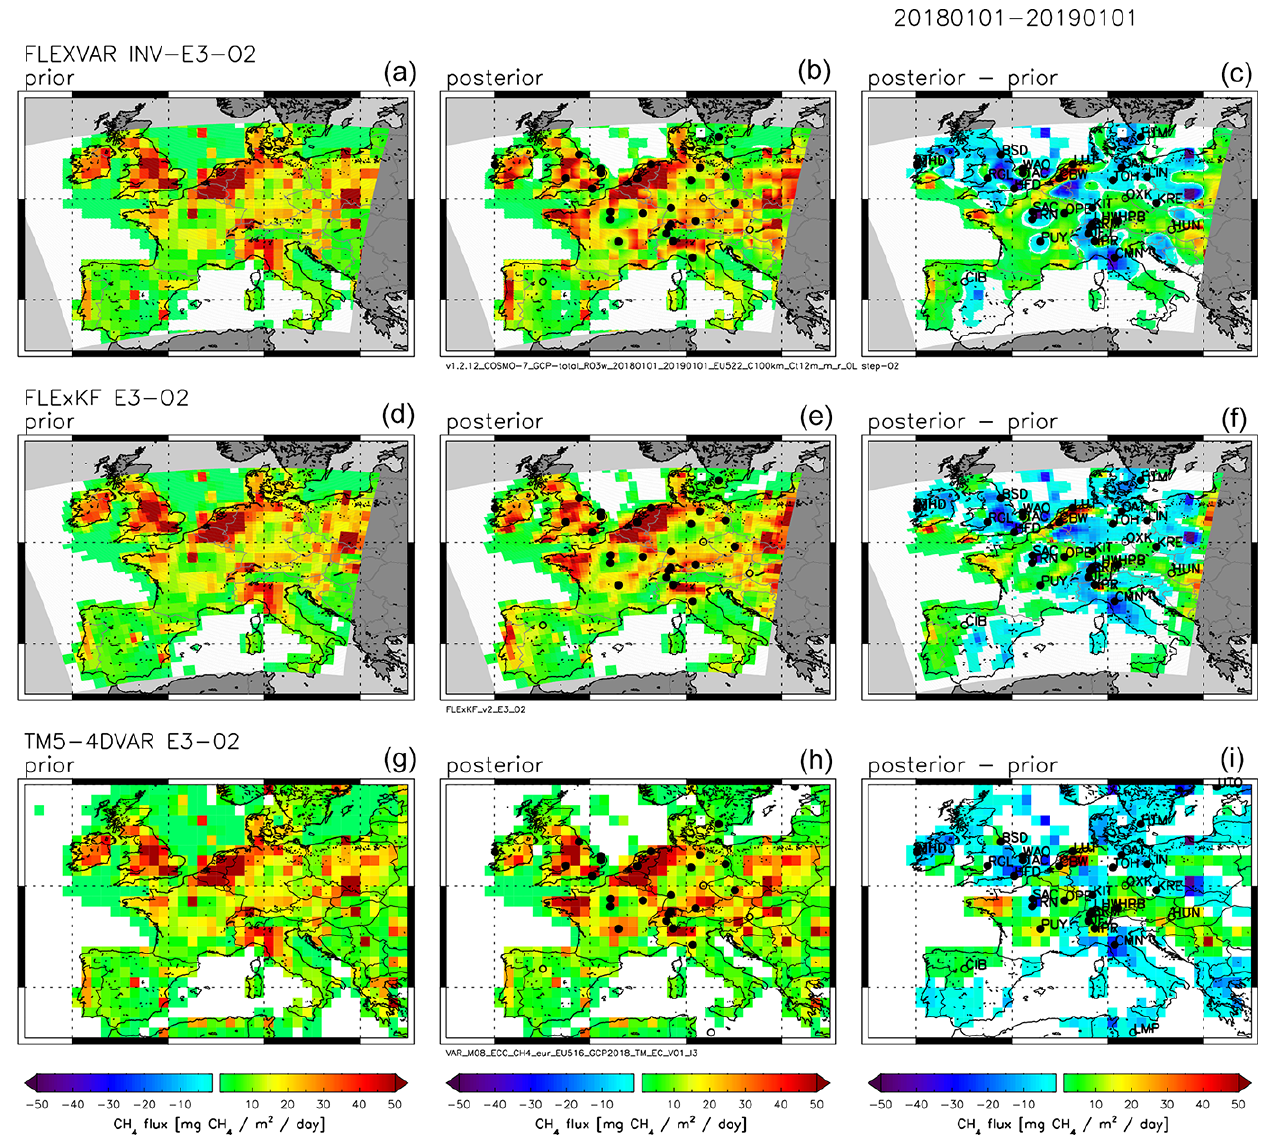
Figure 6. Annual average CH 4 emissions derived for year 2018 using FLEXVAR (a, b, c) , FLExKF (d, e, f) , and TM5-4DVAR (g, h, i) . (a, d, g) Prior emissions. (b, e, h) Posterior emissions. (c, f, i) Difference between posterior and prior emissions. All three inversions shown here use the same inventory data set E3 as prior and the observation data set